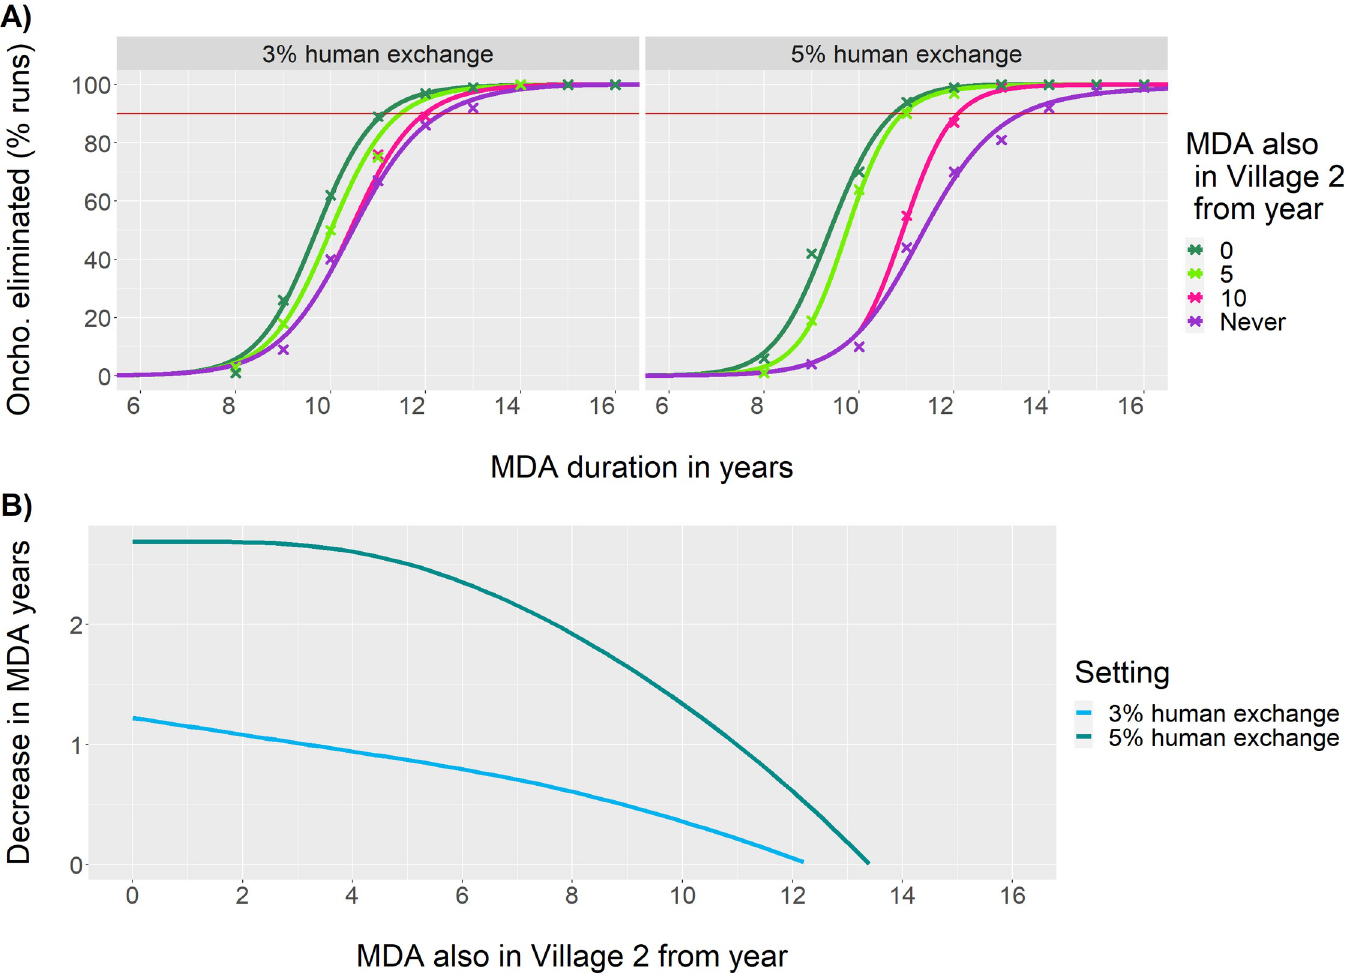
Fig 7. Impact of MDA duration on onchocerciasis elimination when treating inhabitants of spill-over Village 2 fewer years than those of source Village 1, assuming that villagers spend 3% or 5% of their time in the non-home village. ABR Village 1 = 16,000, ABR Village 2 = 8,000. MDA is started at the same time or later in Village 2, but always the end year of MDA in the two villages is concurrent. A) Crosses represent the proportion of runs with onchocerciasis eliminated at 100 years post MDA; lines are logistic fits to these points, see Methods. B) The corresponding fitted estimate of decrease in MDA duration by also treating Village 2